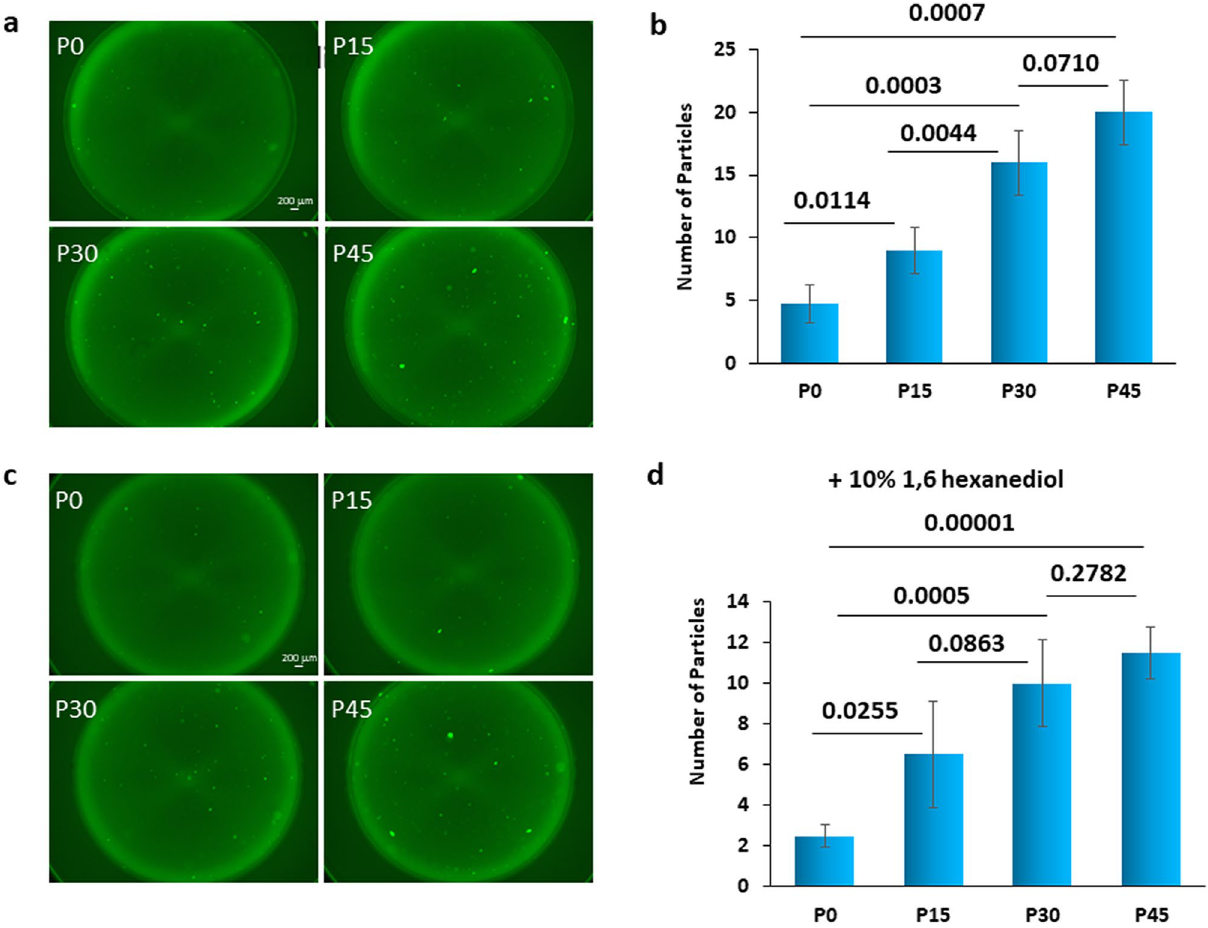
Figure 2. Fluorescence microscope images of FUS aggregates induced by pipetting. ( a ) Representative fluorescence microscope images of FUS fusion protein (Strep-GFP-FUS). The 100 nM Strep-GFP-FUS solution was subjected to pipetting 0, 15, 30, and 45 strokes (P0, P15, P30, and P45, respectively) before measurement. ( b ) A bar graph showing the number of particles > 0.002 mm 2 observed in ( a ). The number of particles was determined with Fiji software. The bar graphs show the averages of three independent experiments ± standard deviation (SD). p values are indicated. ( c ) Images after addition of 10% 1,6-hexanediol, which is known to disrupt the liquid–liquid phase separation, to the samples shown in ( a ). ( d ) A bar graph showing the numbers of particles > 0.002 mm 2 observed in ( c to cause pronounced conformational change of FUS on binding. Here, addition of either R31 or R13 turned out to prevent aggregation of FUS (Fig. 4b–d) as well as that of full-length pncRNA. The decrease in the fluorescence intensity caused by pipetting for all wavelengths was not seen. Then, we examined the suppressive effect of a non-specific counterpart of R13, U 13 comprising thirteen uracil residues. It was found that U 13 cannot protect FUS from aggregation by pipetting. The fluorescence intensity continued to decrease with increasing number of strokes of pipetting (Fig. 4e,f). This indicates that suppression of FUS aggregation by R13 is sequence-specific. We further confirmed the difference between R13 and U 13 as to the suppression of FUS aggregation by fluo- rescence microscopy (Fig. 5). Thirty strokes of pipetting were applied for 100 nM Strep-GFP-FUS protein in the absence of RNA, or in the presence of either R13 or U 13 . Samples were examined by fluorescence microscopy (Fig. 5a), and particles larger than 0.002 mm 2 were counted (Fig. 5b). Then, phase separated particles were dissolved by adding 10% 1,6-hexanediol to each well (Fig. 5c), and the particles were counted again, only FUS aggregates being counted (Fig. 5d). This procedure showed that FUS aggregates were significantly less in the presence of R13 than in the presence of U 13 . This result confirmed that the suppression of FUS aggregation by R13 is sequence-specific. Finally, we confirmed the difference between specific and non-specific RNA on the suppression of FUS aggregation by TEM imaging (Fig. 6). In the presence of R13, only a few small aggregates were observed after applying 30 strokes of pipetting (Fig. 6a). On the other hand, many aggregates of various sizes were observed after applying 30 strokes of pipetting in the presence of U 13 (Fig. 6b). Salt effect on FUS aggregation. Next, the effect of salt on FUS aggregation induced by pipetting was examined. Thirty strokes of pipetting were applied to 100 nM FUS fusion protein at 50 mM NaCl concentration to induce FUS aggregation. The reduction in fluorescence intensity due to aggregation was more when the num-